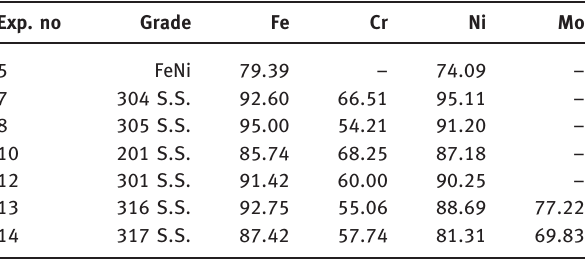
Table 4: Metal recovery ratios for the alloying metals in metal- lothermic stainless steel alloys